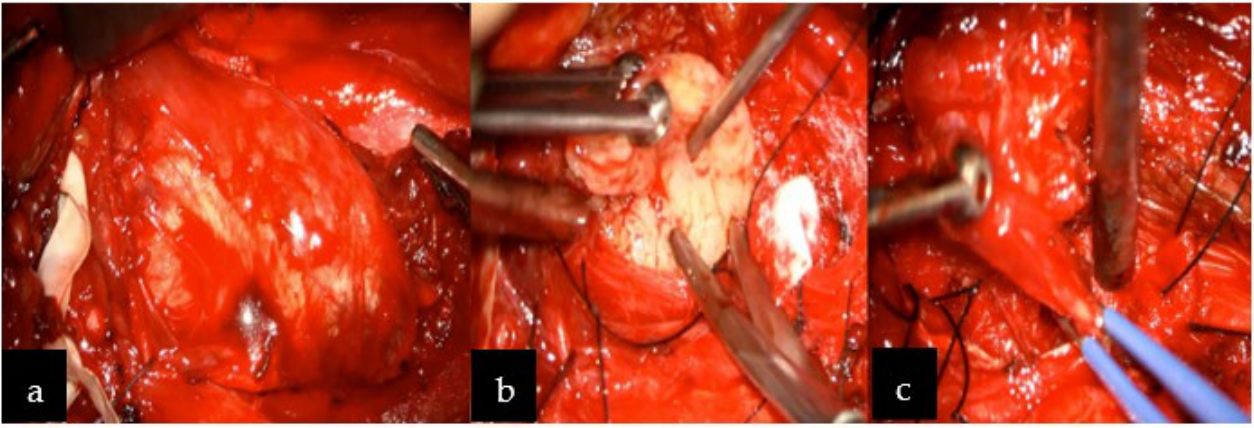
Figure 2. Intraoperative image revealing: ( a ) the paravertebral well-capsulated tumor on the right side at the C2–C4 level, ( b ) after debulking, and ( c ) complete excision was achieved. Below the tumor, vertebral artery was identified (not indicated in the image) and above the tumor, the hypoglossal nerve was visualized (not indicated in the figure).